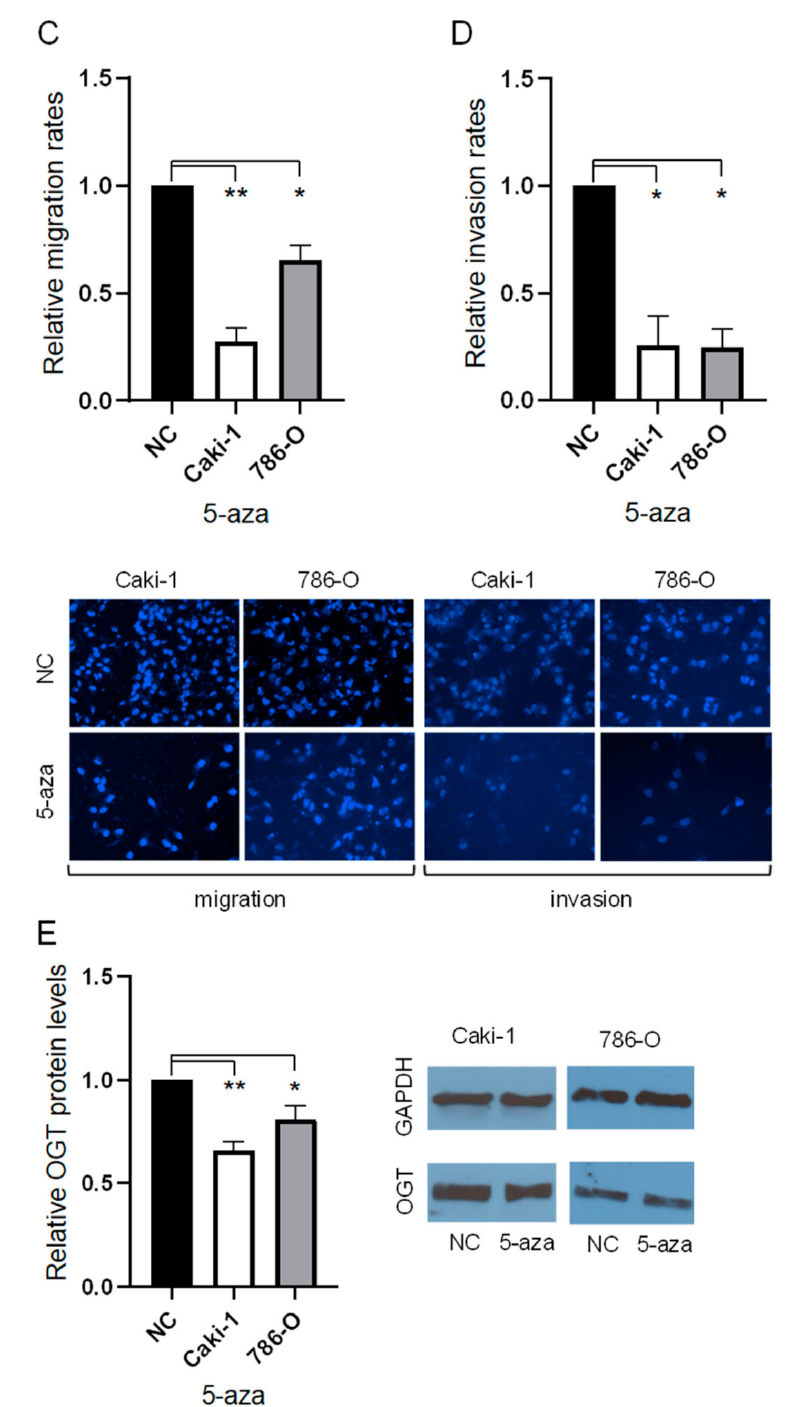
Figure 2. The effects of 10 µ M 5-Aza-2 (cid:48) -deoxycytidine on the ccRCC phenotype and expression of OGT. ( A ) The expression of miR-424-5p in cell lines treated with 5 (cid:48) aza after 48 h, relative to negative control treatment. ( B ) The proliferation rates of cell lines treated with 5 (cid:48) aza after 48 h, relative to negative control treatment. ( C ) The migration rates of cell lines treated with 5 (cid:48) aza, relative to negative control treatment (representative images below, 20 × magnification). ( D ) The invasion rates of cell lines treated with 5 (cid:48) aza, relative to negative control treatment (representative images below, 20 × magnification). ( E ) The OGT protein expression of cell lines treated with 5 (cid:48) aza after 48 h, relative to negative control treatment (representative images aside) (Figures S7–S10). * p < 0.05 and ** p <